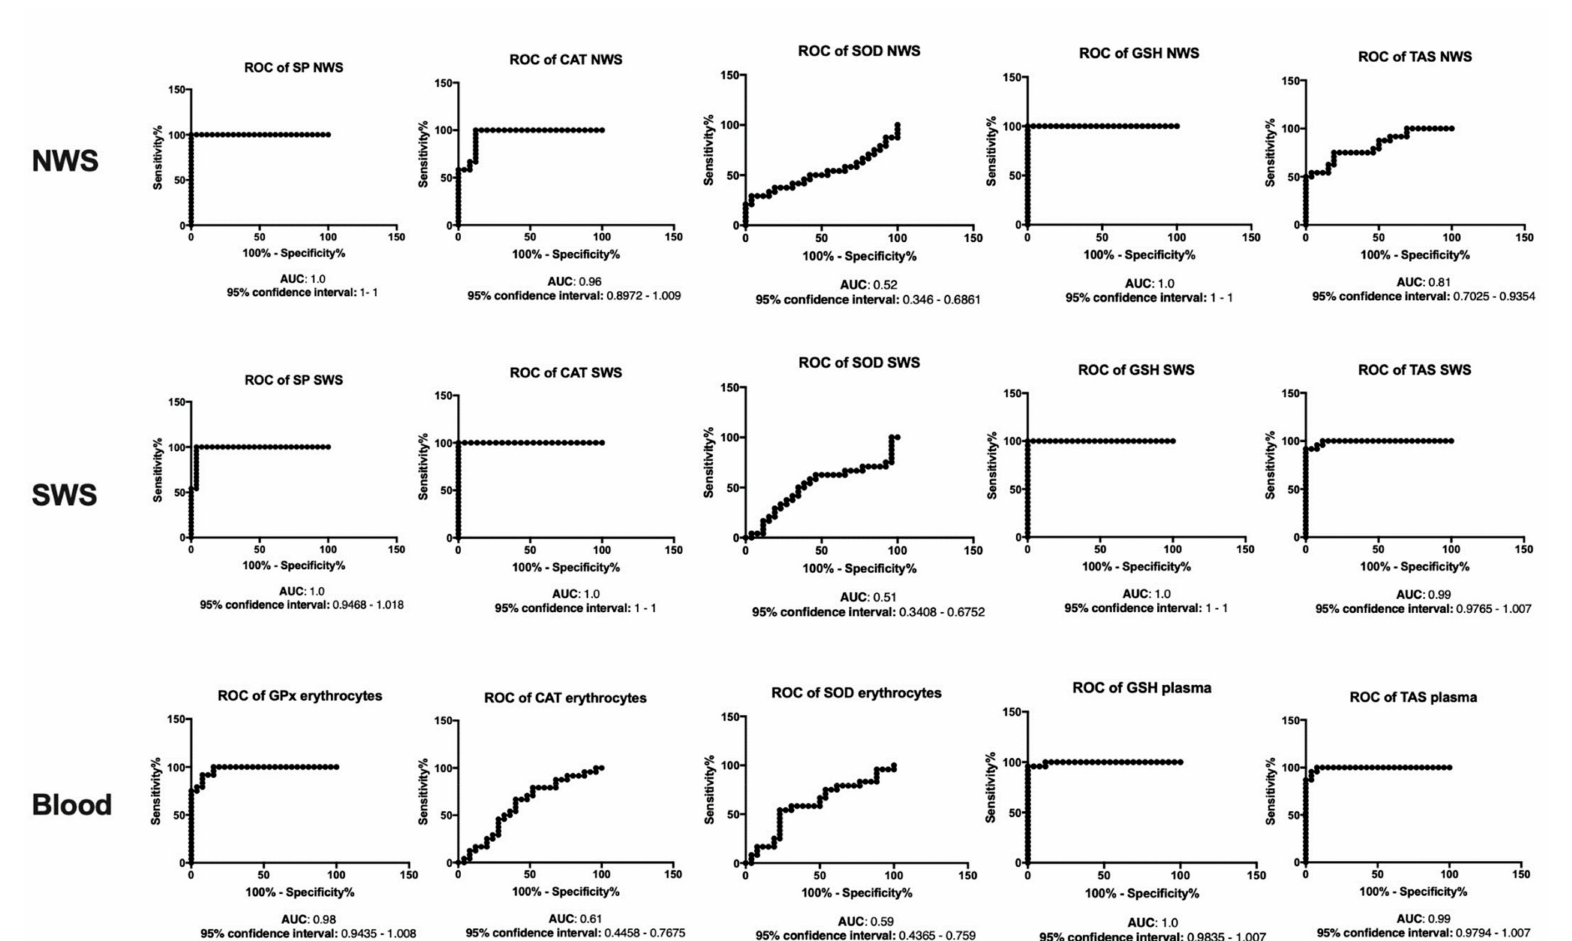
Figure 6. Receiver operating characteristic (ROC) analysis of antioxidants in non-stimulated and stimulated saliva as well as plasma of patients in di ff erent stages of dementia. Abbreviations: AUC—area under the curve; CAT—catalase; GPx—glutathione peroxidase; GSH—reduced glutathione; NWS—non-stimulated whole saliva; SP—salivary peroxidase; SOD—superoxide dismutase; SWS—stimulated whole saliva; TAS—total antioxidant